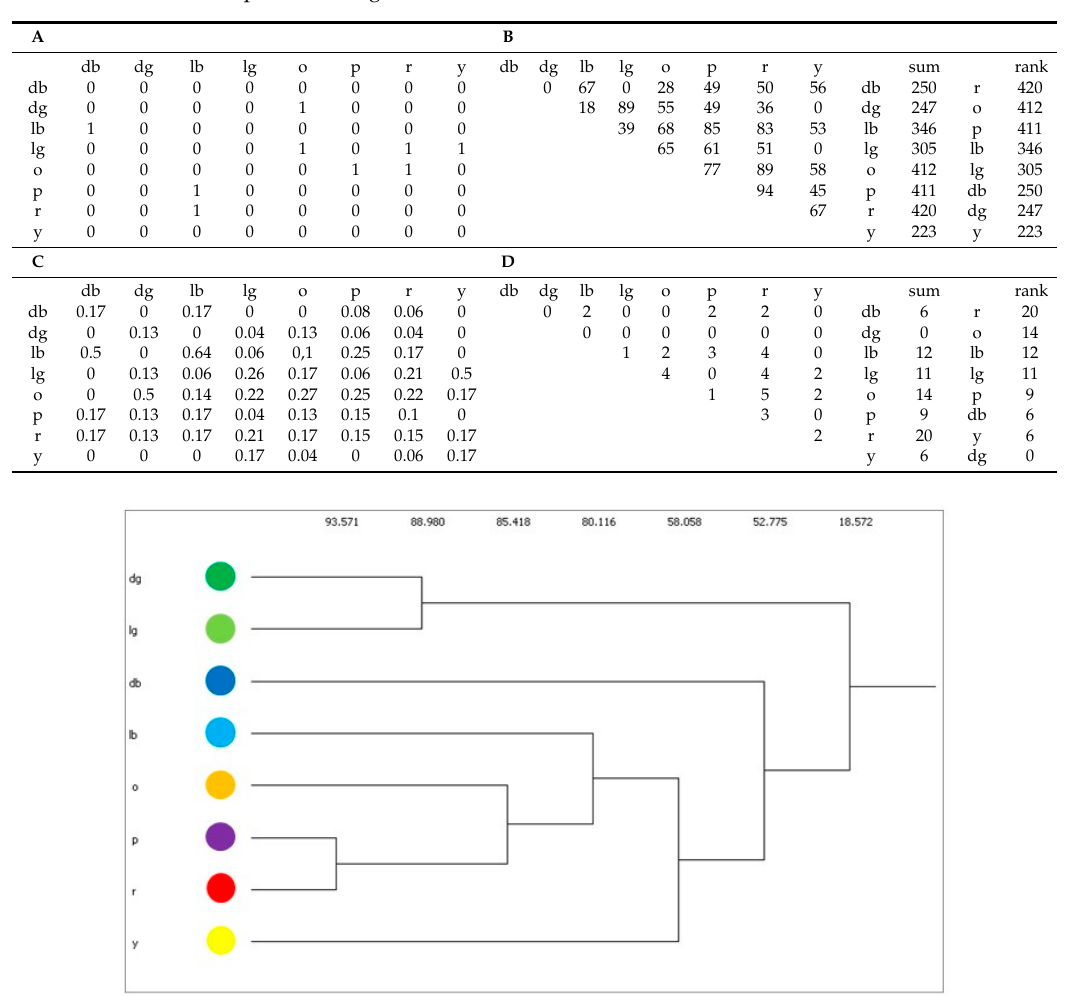
Table 1. The adjacency matrix (A), the regular equivalence (REGE) half matrix (B), the TI matrix (C) and the TO half matrix for the toy network. For REGE and TO we also present the ranking of the nodes. Their color code is explained in Figure 3.